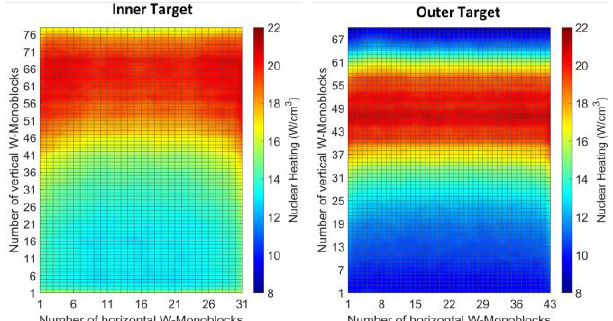
Figure 11. Nuclear heating (W/cm 3 ) distribution on W-monoblocks of the inner ( left ) and outer ( right ) target, with WCLL blanket.